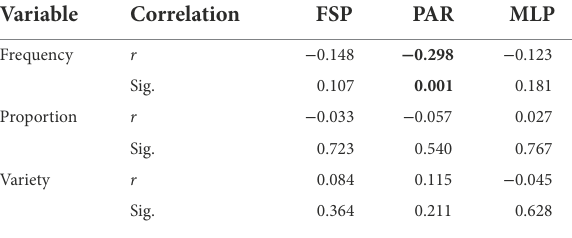
TABLE 4 Correlations between FSs and breakdown fluency. Variable Correlation